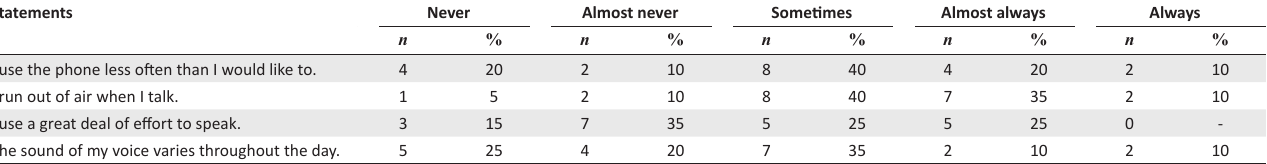
TABLE 5: Voice Handicap Index statements with highest self-rating scores by participants ( n = 20).